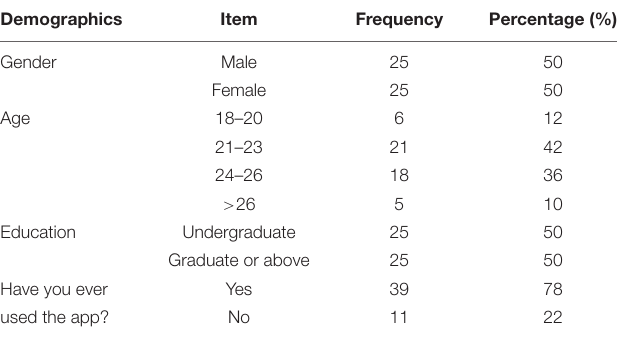
TABLE 3 | Demographic data of the